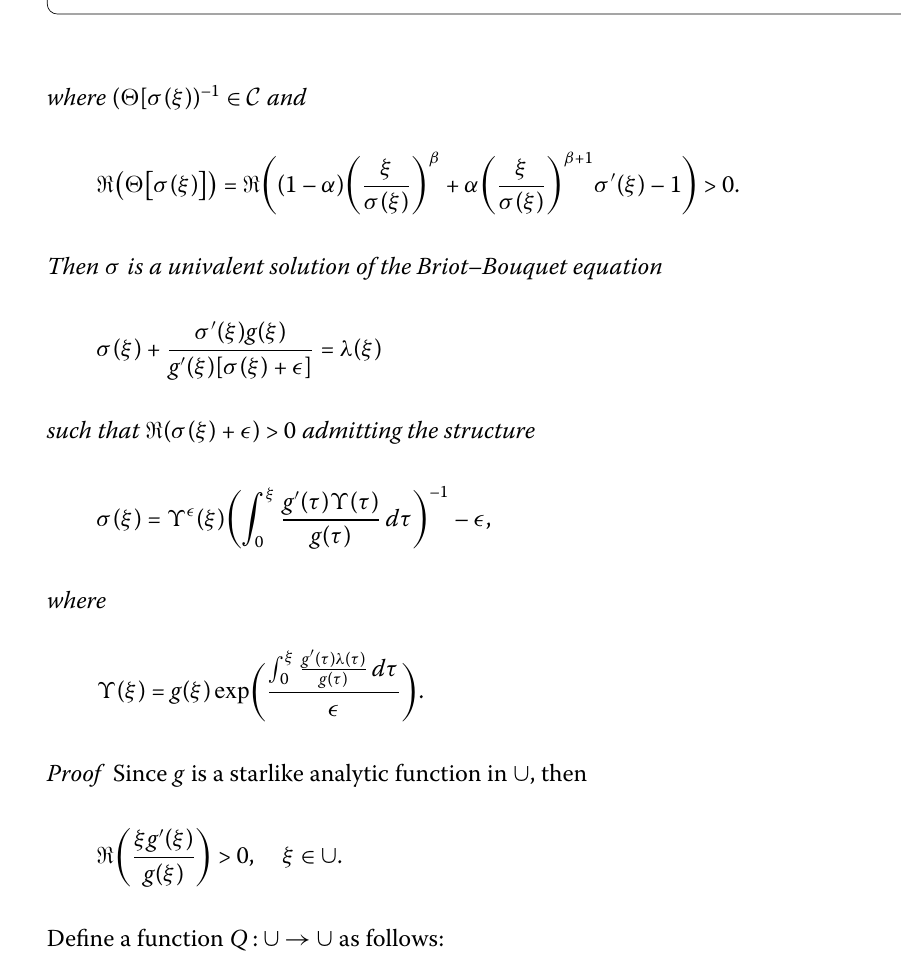
Figure 3 The behavior of solutions of Eq.(3.2), when α = 0.25, β =